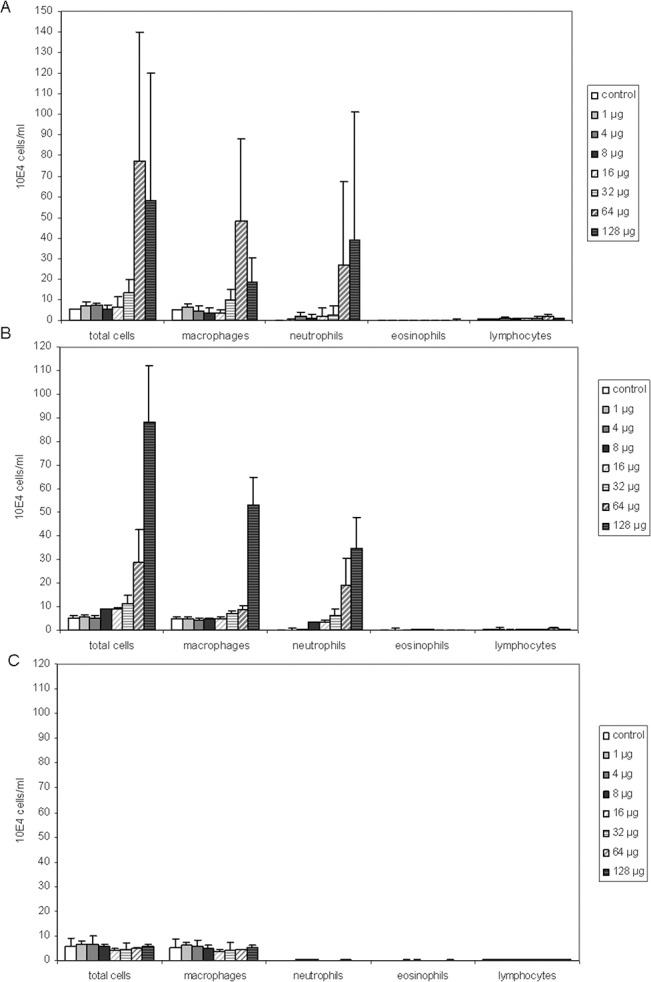
Differential cell counts in BALF.Average total cell numbers and macrophages, neutrophils, eosinophils and lymphocytes (n = 3), 24 hours after nanomaterial instillations with A) non-functionalised ZnO, B) functionalised ZnO and C) Ag NMs. The dose is the representative of μg of NM instilled per mouse. Error bars represent the standard deviation.